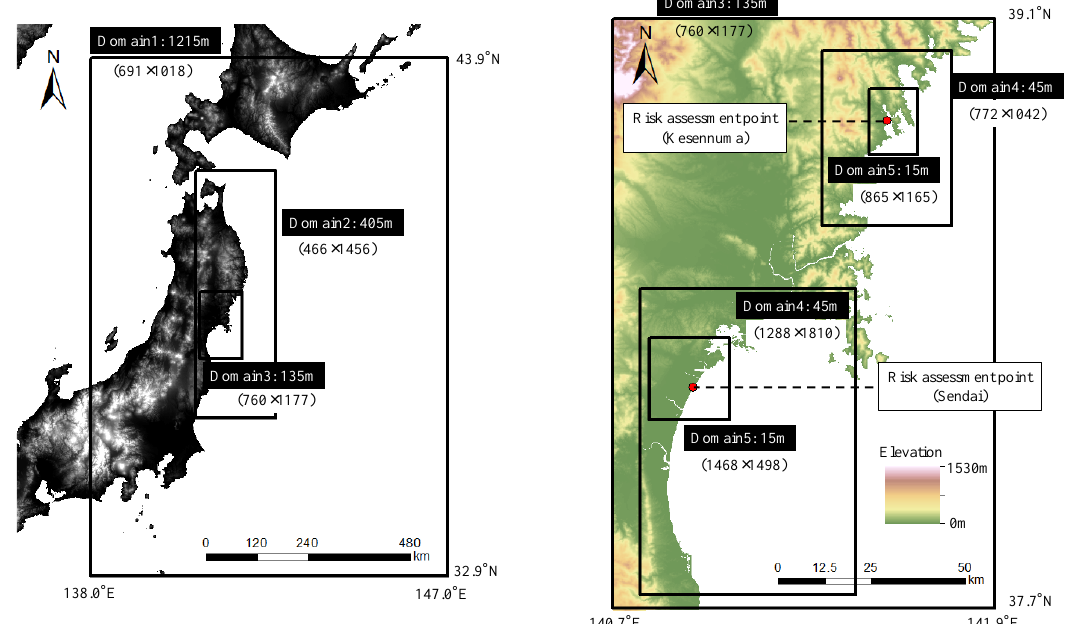
Figure 10. Five regions of terrain data used for the tsunami numerical run-up simulations in the Sendai and Kesennuma areas (Domain 1, Domain 2, Domain 3, Domain 4 and Domain 5). The numbers in parentheses are the east-west and north-south mesh